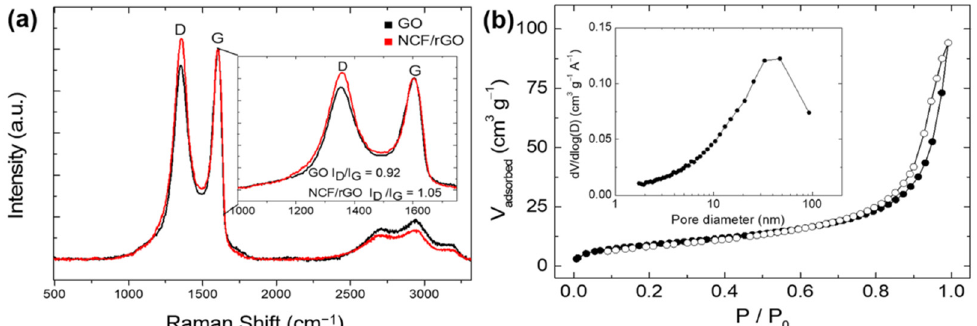
Figure 3. ( a ) Raman spectra of the GO and NCF/rGO samples; ( b ) Nitrogen physisorption isotherm and Barrett–Joyner–Halenda (BJH) pore size distribution (inset) of the NCF/rGO nanocom- posite.